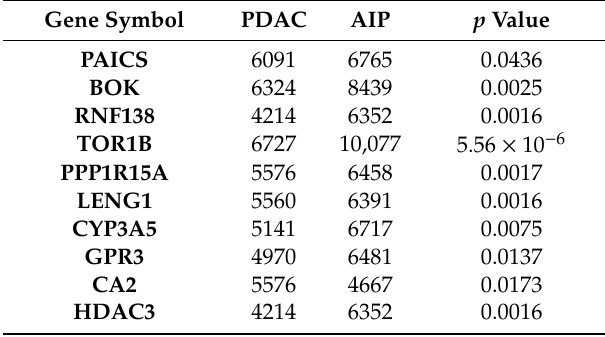
Table 4. Autoantigens and their corresponding reactivity in PDAC and AIP patients’ sera. Selected autoantigens and their normalized autoantibody levels (log of median fluorescence intensity). Gene Symbol PDAC AIP p Value PAICS